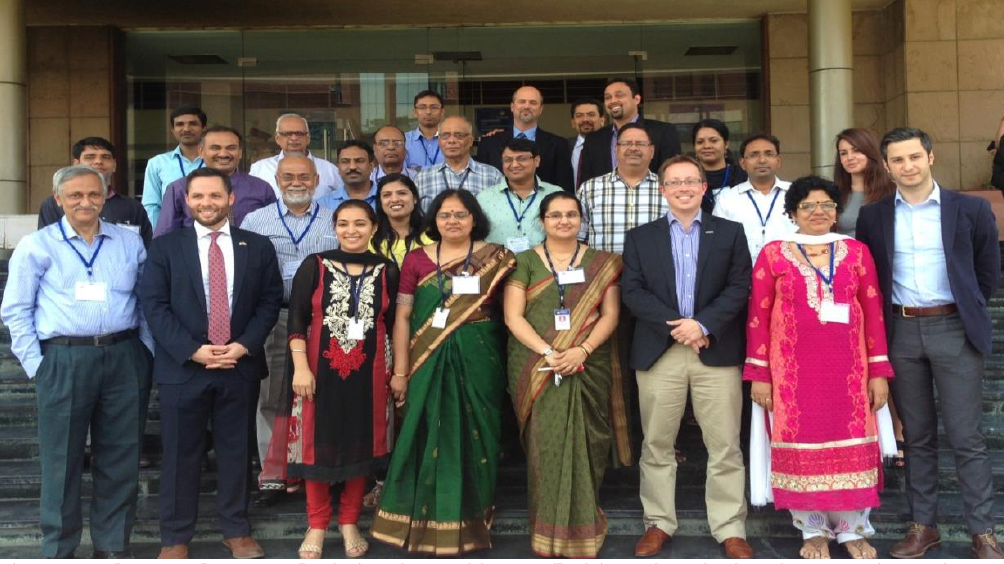
Figure 1. Delegates Alpana Goel, Christopher Hobbs, Sunil Chirayath, Sukesh Aghara, Craig Marianno, and participants in the first week of the PDC held from June 1-5, 2015, at Amity University of Uttar Pradesh,